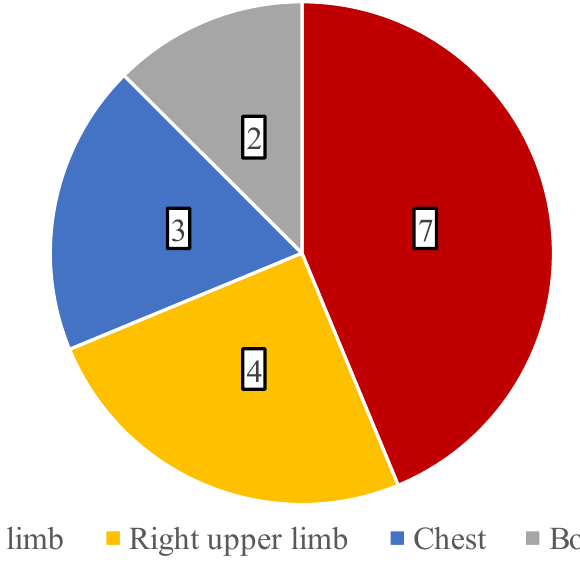
Figure 5. The distribution of burned areas associated with facial combustions.